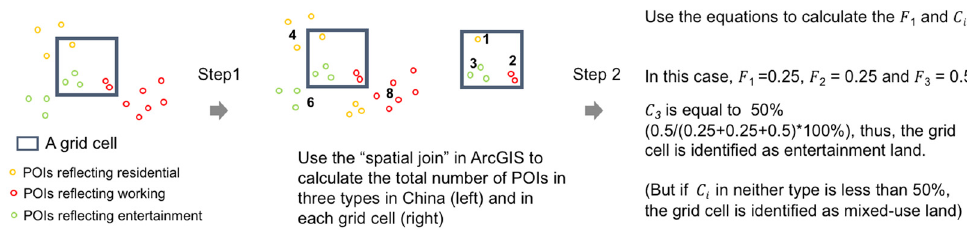
Figure 1. Identifying the land use categories for every grid cell in China.